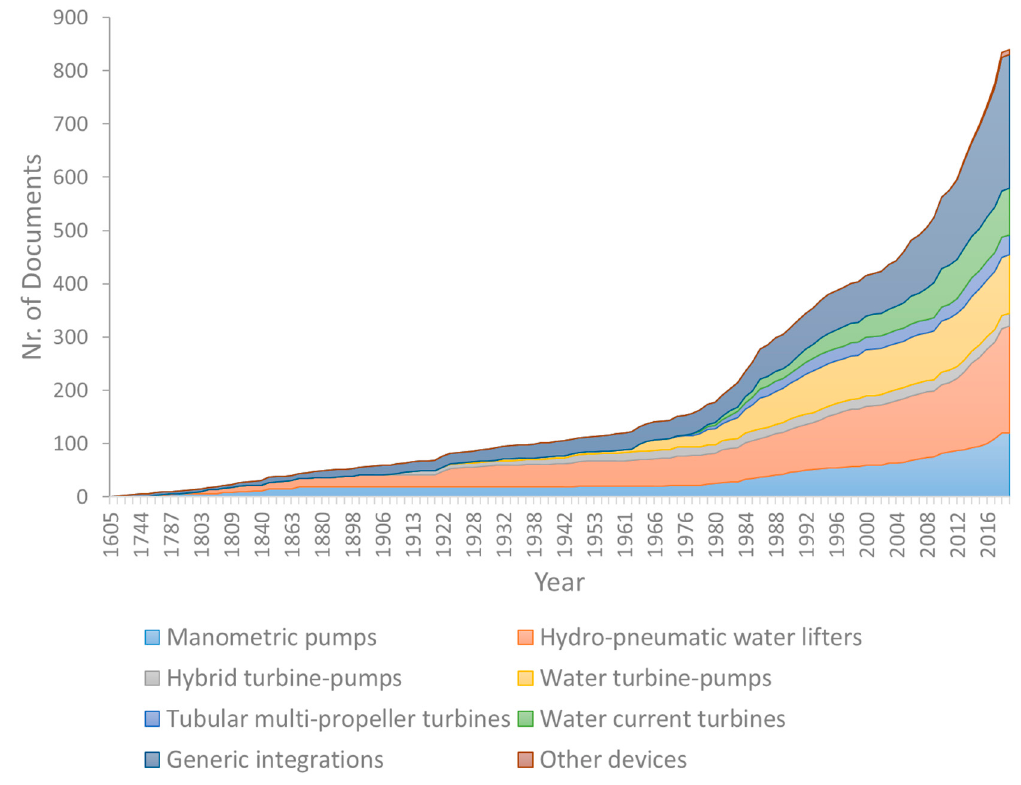
Figure 11. Cumulative number of selected documents published over time. The different colored areas depict the running total of documents produced per category of technology per year.